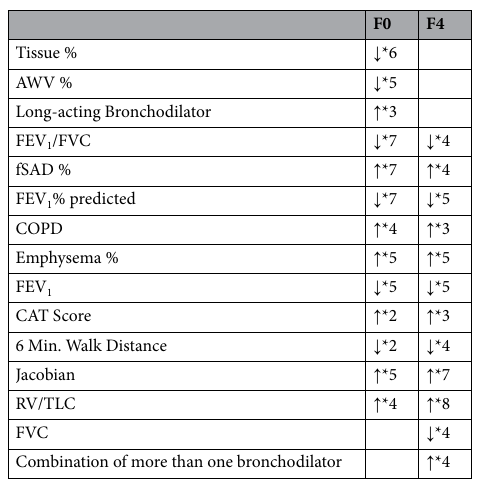
Table 2. Comparisons of the associations with known variables between F0 and F4. The numbers in the table represent the strength of correlation with the factors. An increment of the number represent a 0.1 difference of